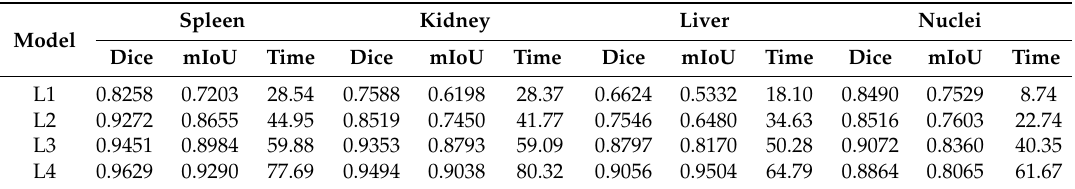
Table 8. Segmentation results of four pruned models. The inference time (counted by seconds) is calculated by segmenting 1K